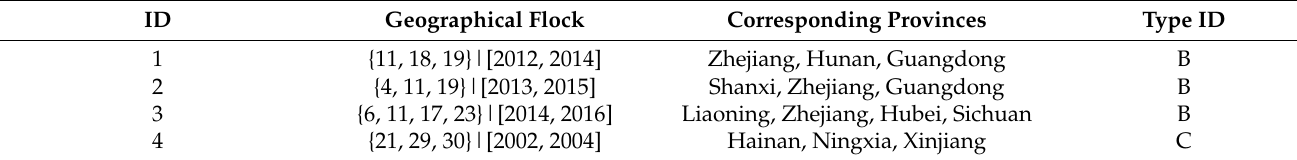
Table 3. The discovered geographical flock patterns based on the criterion of the high–low attribute values on the province